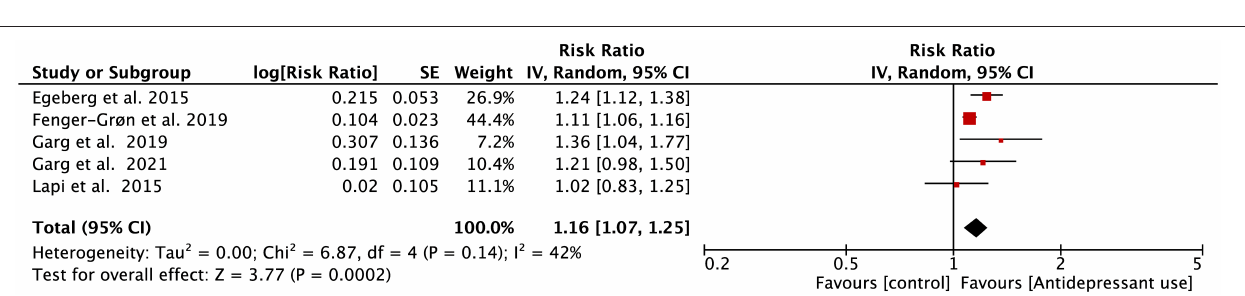
FIGURE 2 | Forest plot for association of depression with atrial fibrillation risk. SE, standard error; CI, confidence interval; IV, inverse of the variance.